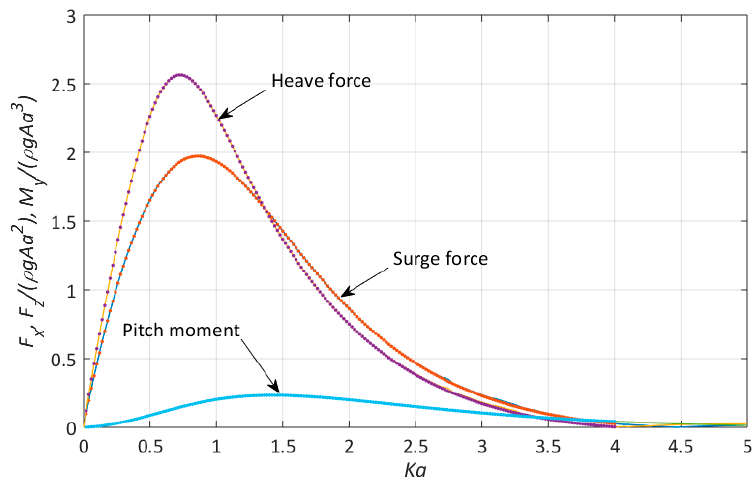
Figure 2. Magnitudes of the hydrodynamic loading acting on an oblate spheroid that approximates a sphere 𝑎 𝑏⁄ ~1 immersed at 𝑓 𝑎⁄ ~1 and 𝑓 𝑎⁄ = 1.5 . The sphere is subjected to regular wave action. Solid line: surge force 𝑓 𝑎⁄ ~1 ; dashed line: heave force 𝑓 𝑎⁄ ~1 ; chained line: surge force 𝑓 𝑎⁄ = 1.5 ; dotted line: heave force 𝑓 𝑎⁄ = 1.5 .